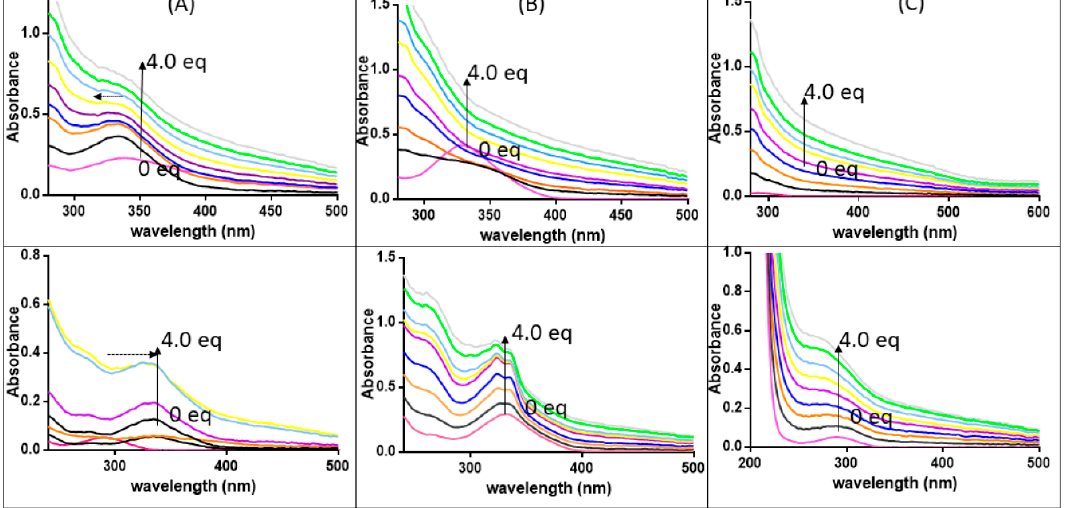
Figure 4. Absorption spectra of 1 (panel A ), 2 (panel B ), and 3 (panel C ) upon the addition of NPM1 264–277 (top) and A β 21–40 (bottom) at different equivalents. (0 eq fuchsia, 0.5 eq black, 1.0 eq orange, 1.5 eq blue, 2.0 eq violet, 2.5 eq yellow, 3.0 eq light blue, 3.5 eq green, 4.0 eq grey) Vertical arrows indicate changes in intensity, horizontal arrows indicate shifts of λ max.